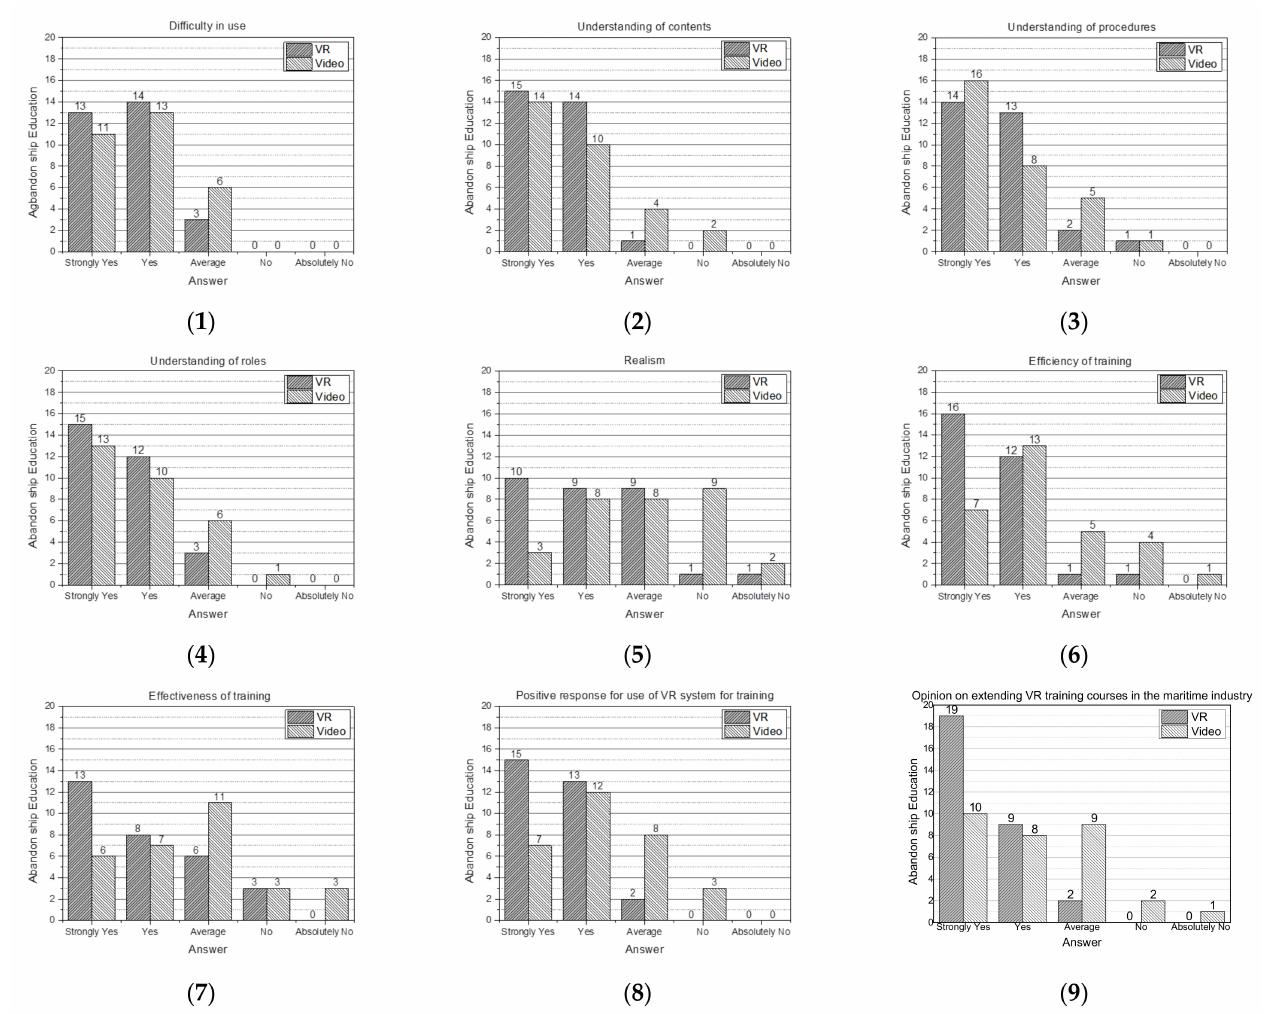
Figure 5. Education satisfaction comparison between video clip and VR training (top to bottom and left to right): ( 1 ) Difficulty in use, ( 2 ) understanding of contents, ( 3 ) understanding of procedures, ( 4 ) understanding of roles, ( 5 ) realism, ( 6 ) efficiency of training, ( 7 ) effectiveness of training, ( 8 ) positive response for use of VR system for training, ( 9 ) opinion on extending VR training courses in the maritime